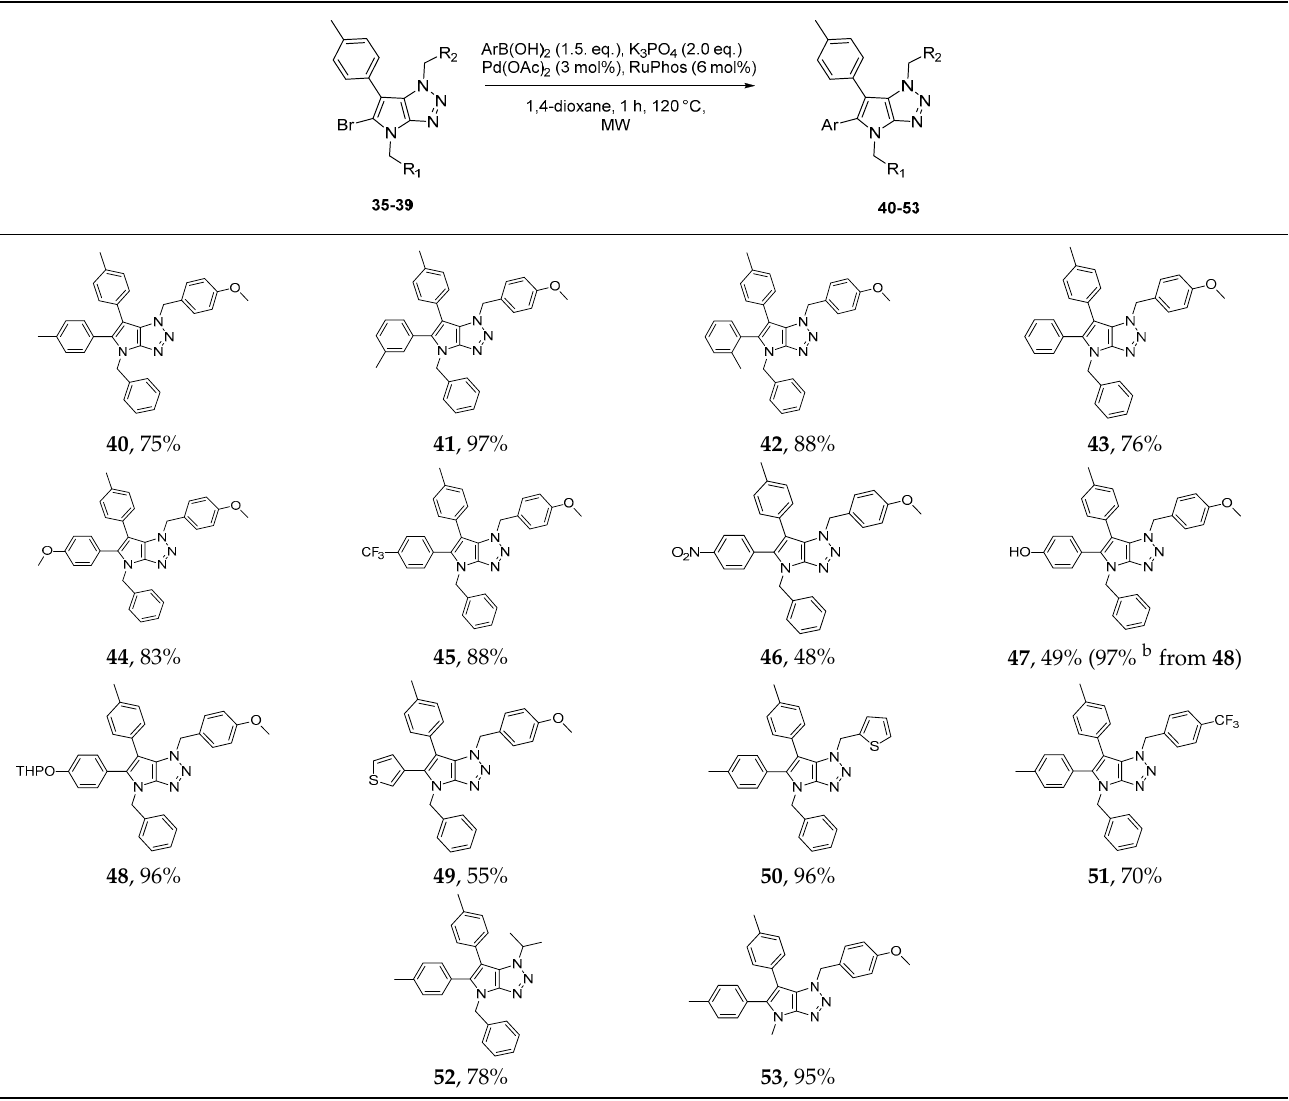
Table 7. Scope of the Suzuki–Miyaura reaction in C-5 position: s ynthesis of 40 – 53 a . a Yields are calculated after isolation of the products.